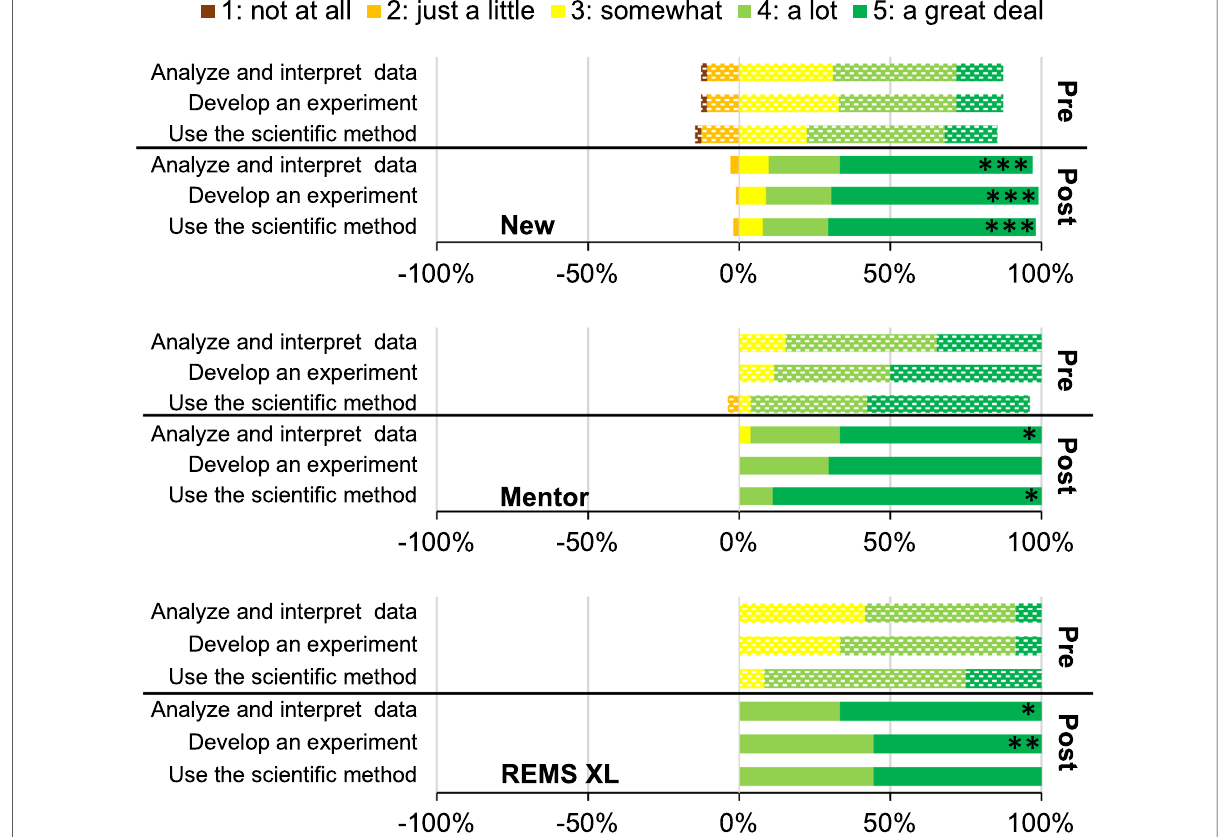
Fig. 12 Competence: Pre- and post-program student science skills competence. Responses to REMS survey science skills competence items (1 Not at all, 5 A great deal) collected from New Students ( N = = scores were analyzed with Mann–Whitney U -tests. * p < 0.05. ** p < 0.01. *** p <